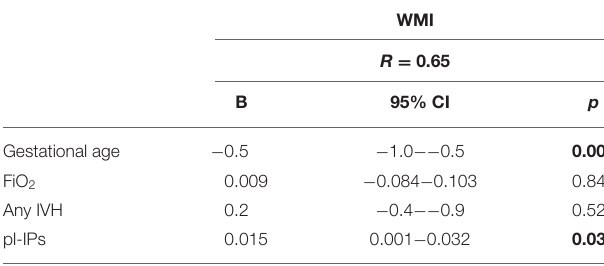
TABLE 4 | Multivariable linear regression analysis correlating pl-IPs between 24 and 48h after birth and WMI score at TEA.